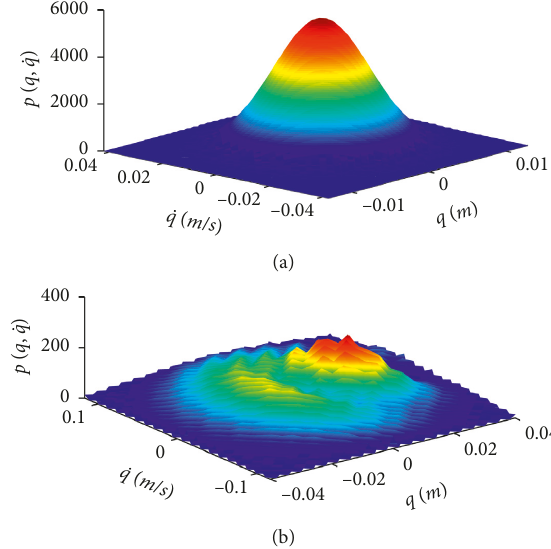
Figure 11: Joint PDF of displacement and velocity. (a) N (b) N p (cid:31)